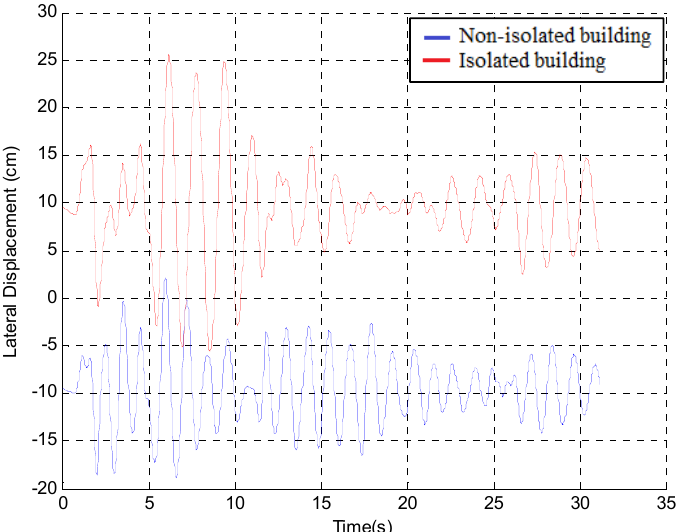
Figure 5. Lateral displacement time histories of non ‐ isolated and isolated building with a 19 cm gap.